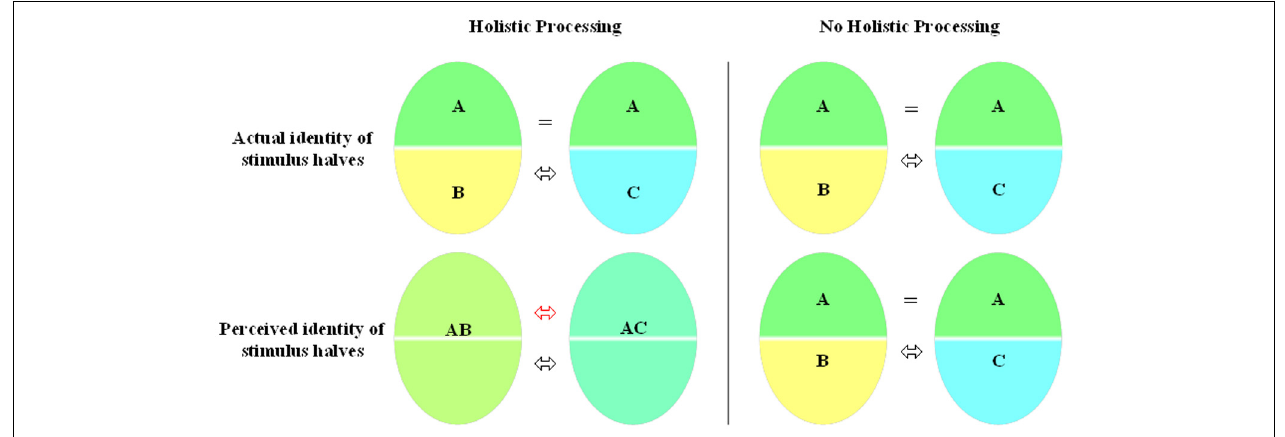
FIGURE 1 | Holistic processing explained within an identity-based composite paradigm. In this example, participants have to judge the identity of the top part of the stimulus. Differential predictions can be made depending on the visual processing strategy that is involved in perceiving a stimulus class. On the one hand, when a stimulus class is processed